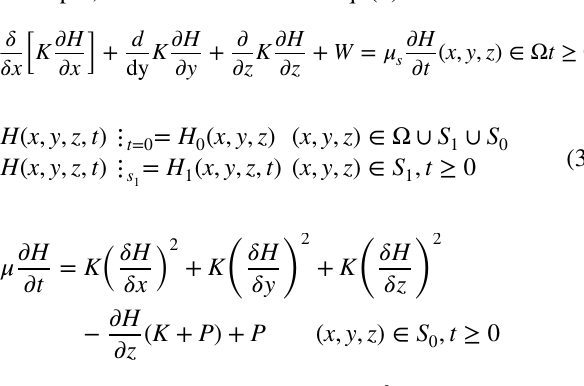
Table 1 Aquifer properties